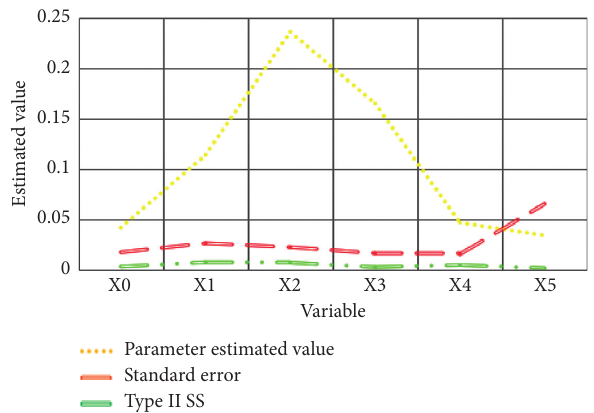
Figure 6: Significance test of regression parameters.